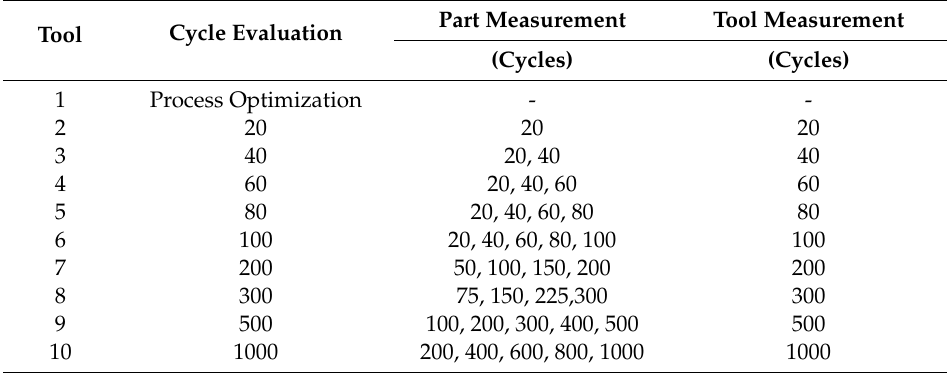
Table 6. Injection molding experimental plan for 3D printed tooling inserts life investigation.